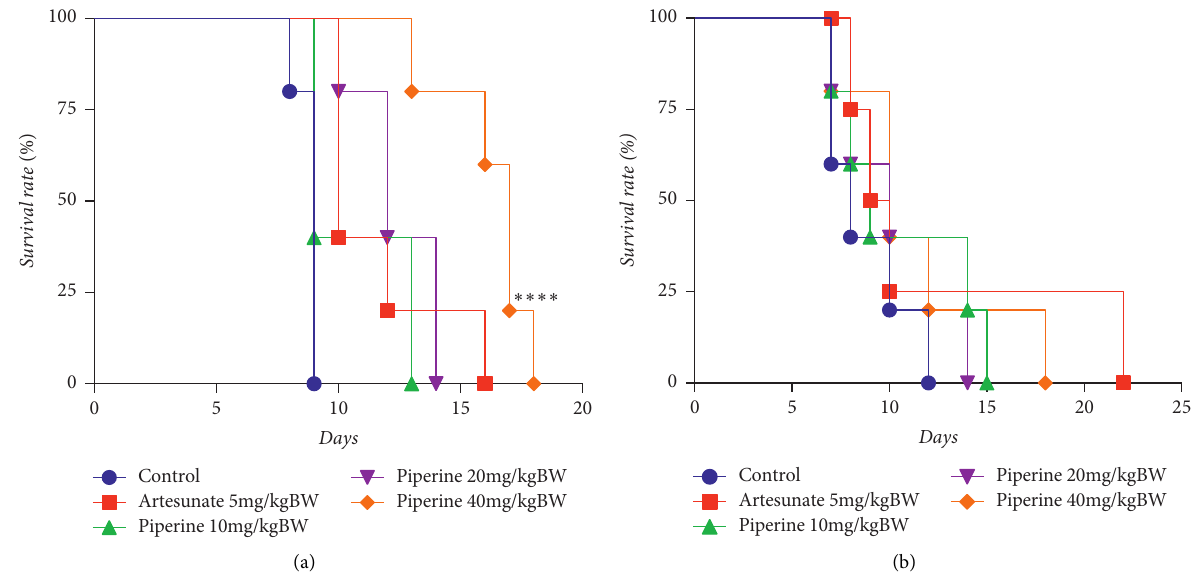
Figure 6: Survival rate after piperine administration in mice infected with P. berghei ANKA in the (a) curative test and (b) prophylactic test. ∗∗∗∗ p < 0 . 0001 compared with negative control (Kaplan–Meier survival curve).